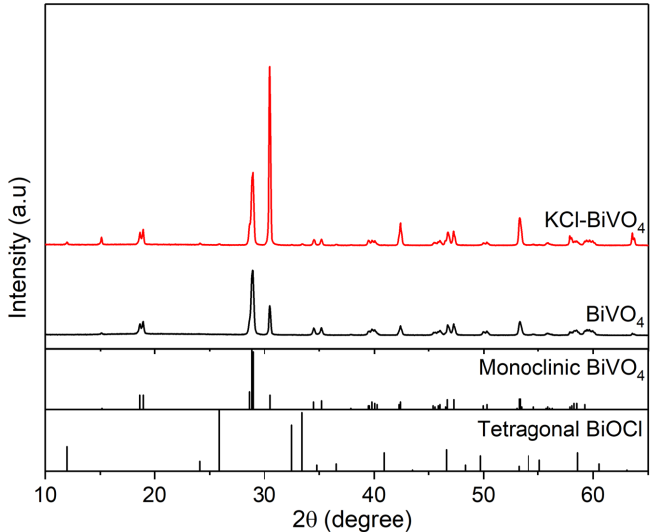
Figure 2. XRD patterns of pristine BiVO 4 and KCl-BiVO 4 .